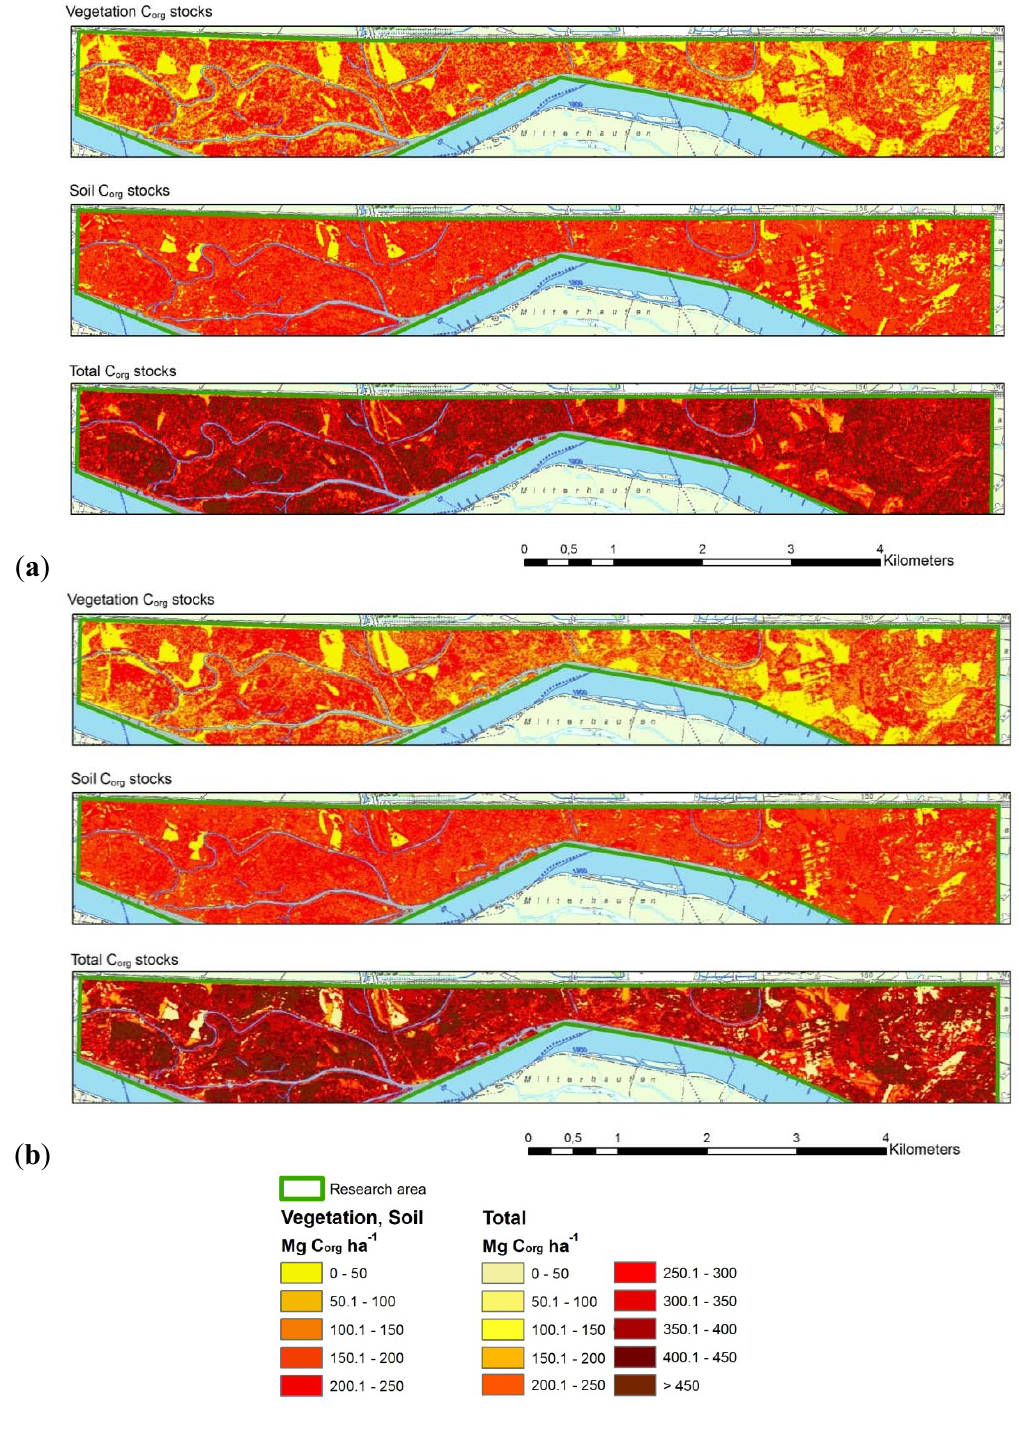
Figure 3. ( a ) C stocks in vegetation (above), soil (middle) and total (below), calculated org by SOM method based on RapidEye; (b ) C stocks in vegetation (above), soil (middle) org and total (below), calculated by SOM method based on RapidEye and additional